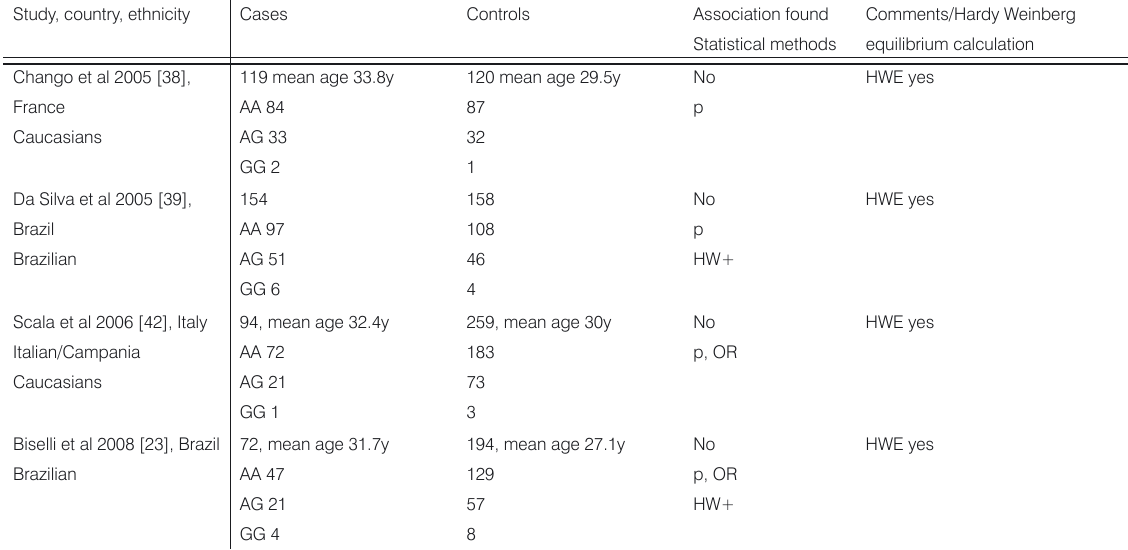
Table 5. Characteristics of studies on MTR 2756 A>G polymorphisms in mothers of DS children.